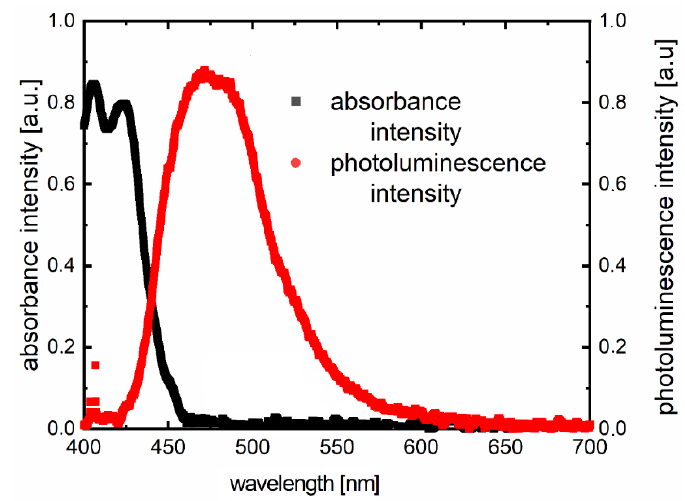
Figure 4. Example of the Stokes shift for sample F3 from Table 2. The photoluminescence has been excited by a diode laser ( λ ex = 405 excited by a diode laser (λ ex = 405 nm).